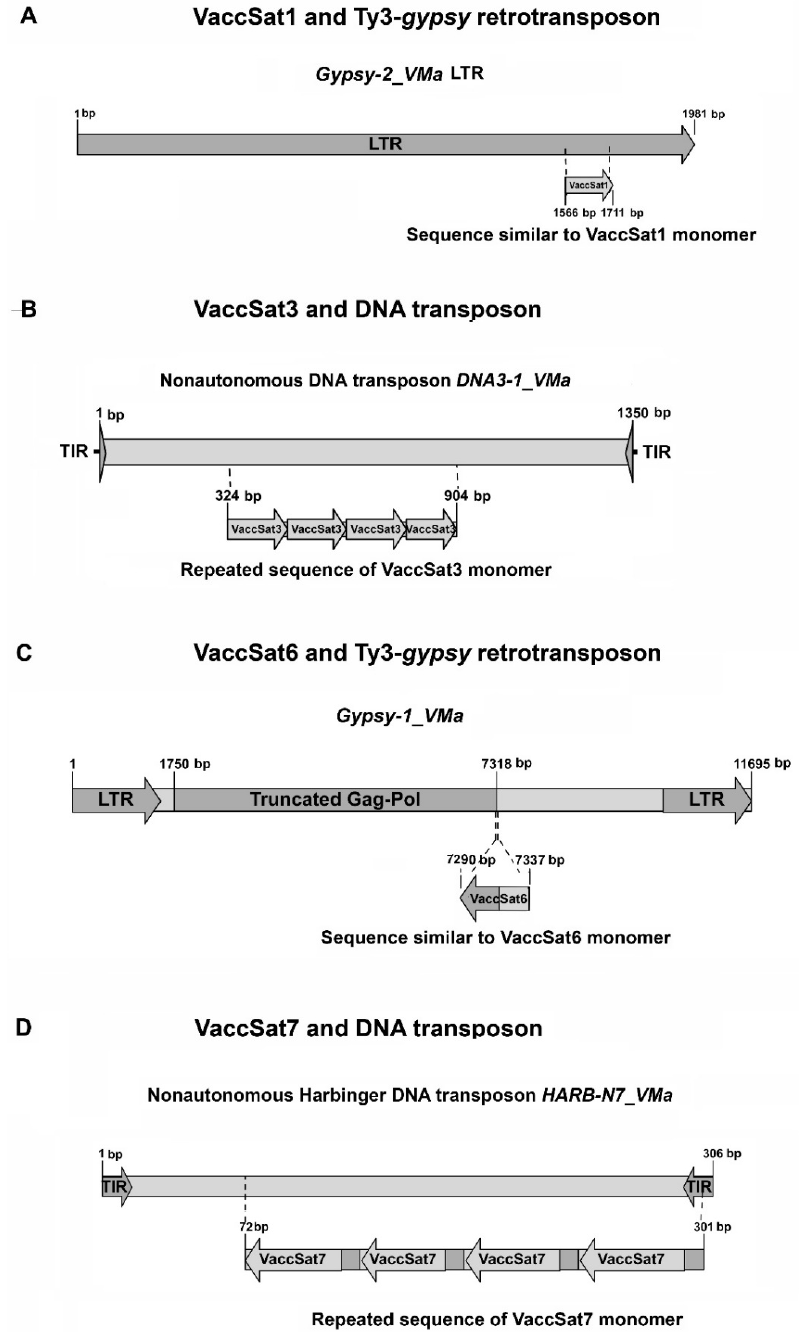
Figure 4. Schematic diagrams of satellite–TE associations in V. macrocarpon . ( A ) A VaccSat1-like sequence has been detected in solo-LTRs of the Gypsy-2_VMa retrotransposon family. ( B ) Four tandem VaccSat3 units has been identified within DNA3-1_VMa, a nonautonomous DNA transposon family. ( C ) A VaccSat6-like sequence has been detected within Gypsy-1_VMa retrotransposon family. Darker rectangle shows the truncated Gag-Pol protein coding region. ( D ) Four tandem VaccSat7 units has been detected within HARB-N7_VMa nonautonomous Harbinger -type DNA transposon family. Here, the rectangles represent transposable elements (TEs) and arrows represents long terminal repeats (LTRs) region or terminal inverted repeats (TIRs) region satDNA monomer.